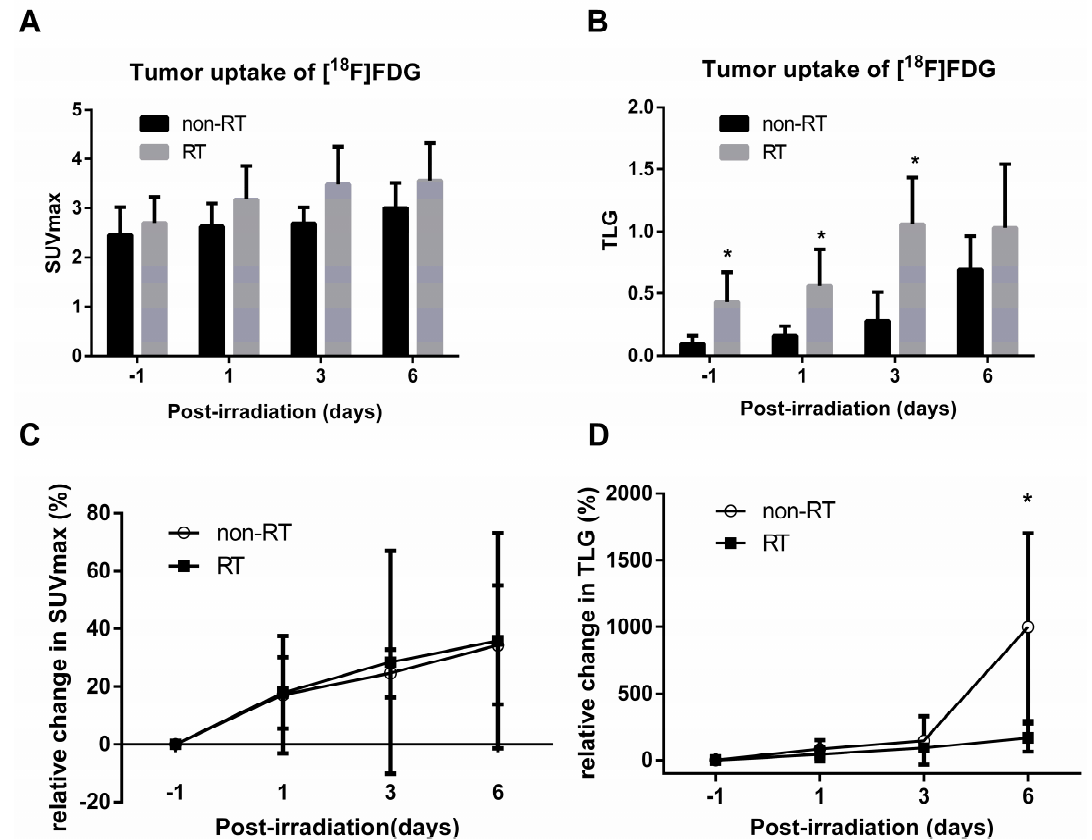
Figure 3. Semi-quantification of [ 18 F]FDG. Averaged A , SUVmax B, TLG of tumors and averaged C SUVmax and D TLG changes (%) from baseline in RT and non-RT groups. * p < 0.05. At post-irradiation Day 1 and Day 3, the SUVmax and TLG of tumors were higher than that of non-RT tumors. On the contrary, the degree of Δ TLG of RT tumor was significantly lower at Day 6.